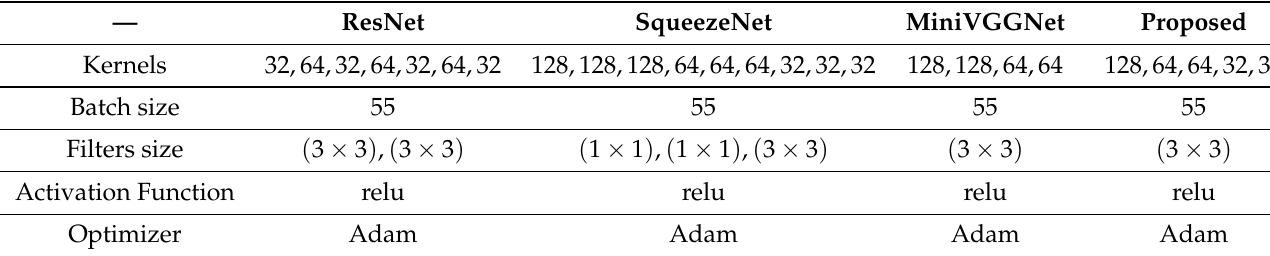
Table 3. Layer-wise settings of all comparative